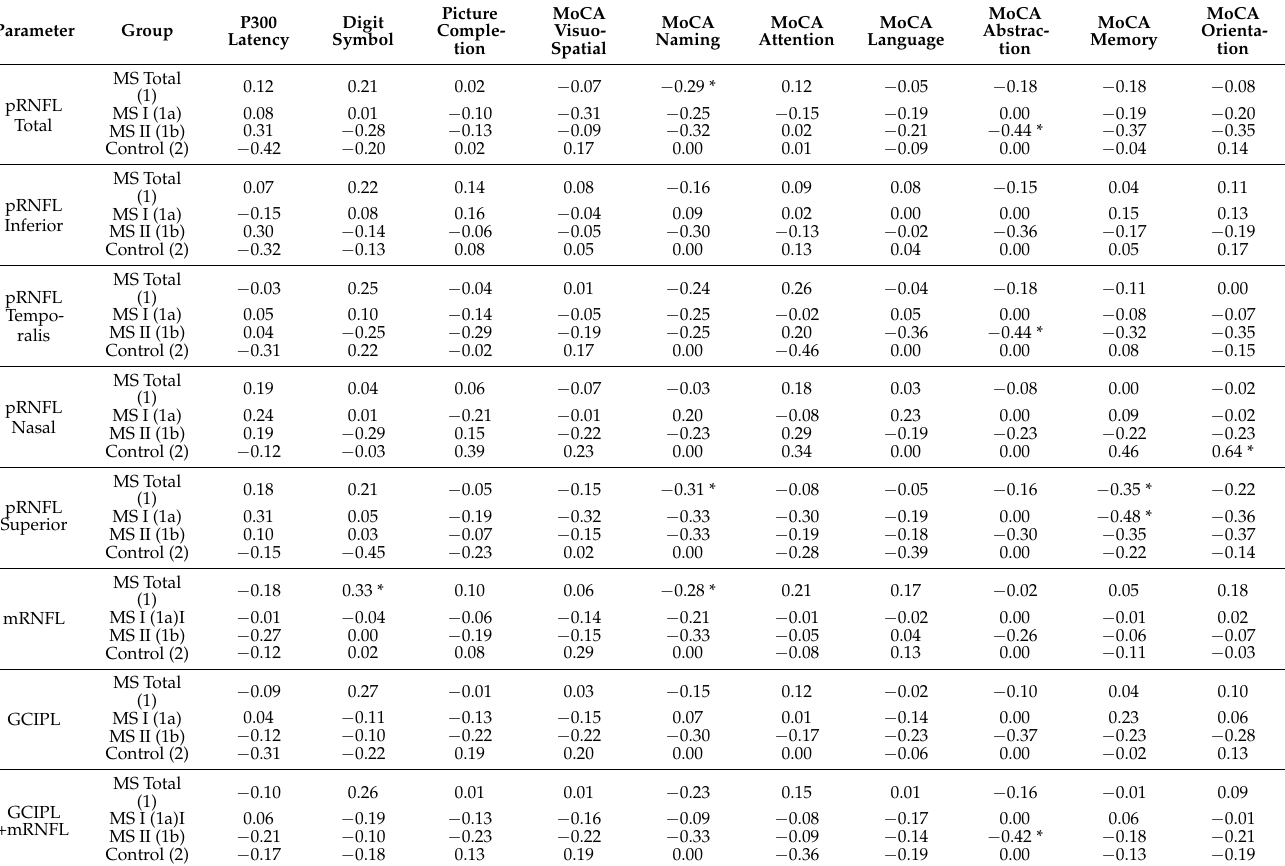
Table 5. Correlation between the OCT parameters and the results of psychometric tests.